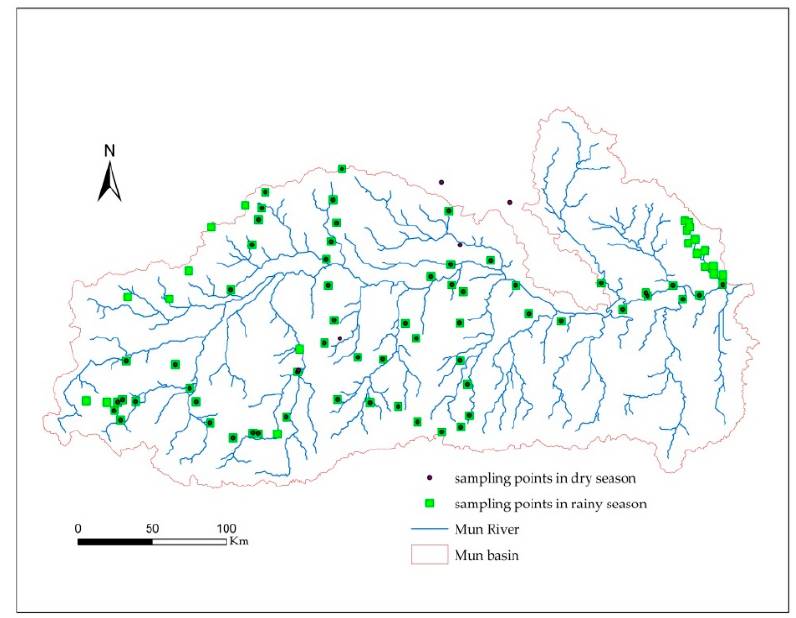
Figure 4. Location map of soil sampling points.